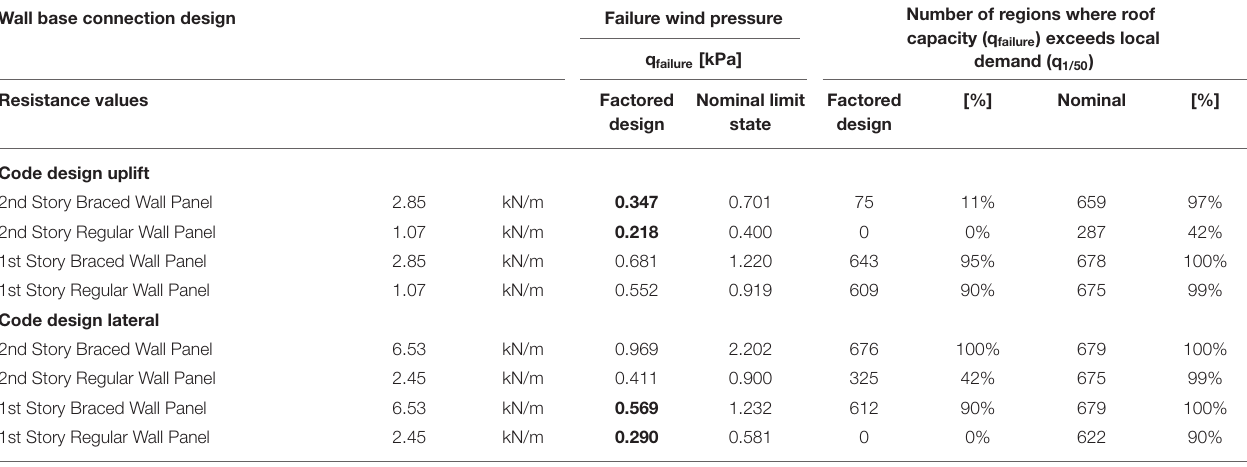
TABLE 5 | Design check for wall anchorage showing factored and unfactored design wind pressures for uplift and lateral load effects, as well as a comparison to the design wind pressures in NBCC (Canadian Commission on Building and Fire Codes, 2015) climate zones.